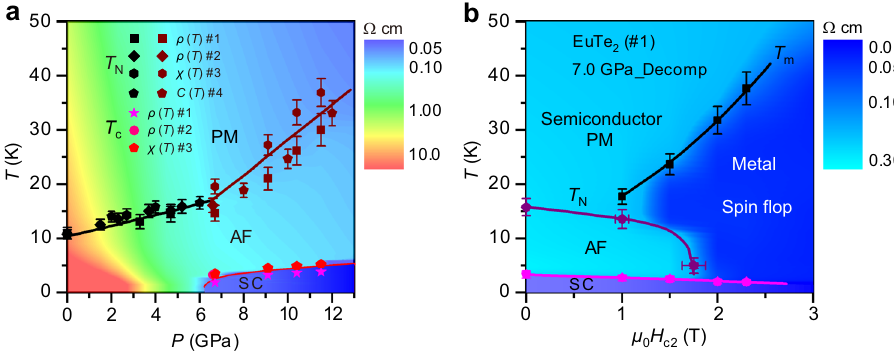
Fig. 5 Phase diagrams of EuTe 2 . a Temperature-pressure phase diagram of EuTe 2 based on the ρ ( T ), χ ac ( T ), and C ac ( T ) data. b Temperature- fi eld phase diagram of EuTe 2 (#1) at ~7 GPa based on the ρ ( T ) data in Fig. 3a. PM, AF, and SC denote paramagnetic, antiferromagnetic, and superconducting phases, respectively. The color indicates the magnitude of resistivity. The error bars of the transition temperatures in ( a , b ) are estimated from the width of the transitions.